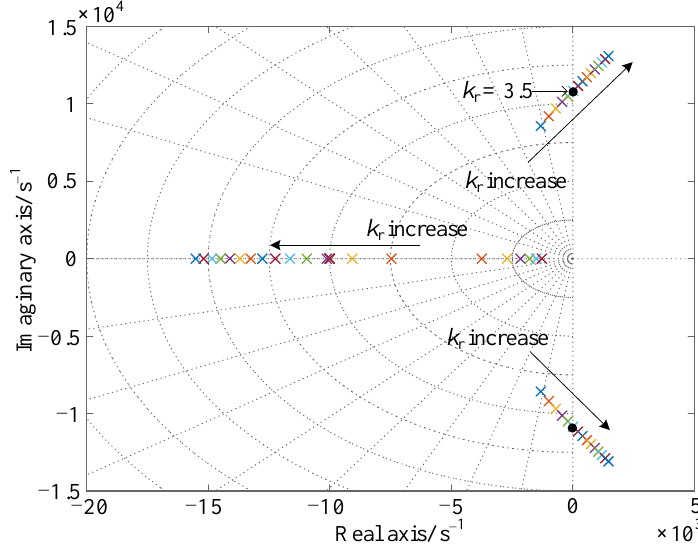
Figure 12. The pole distribution diagram of G i_cl ( s ) under different k r . In order to theoretically prove the suppression effect of G R ( s ) on the 6th harmonic component in i d , when k r increases from 1 to 3, the bode plot of G u_i ( s ) is shown in Figure 13. Due to the addition of G R ( s ), the amplitude around 1000 Hz is below 0 dB line. And with the increase of k r , the suppression effect on the 6th harmonic component in i d is more significant, and the band of the voltage harmonic frequency that can be suppressed by the G R ( s ) will also expand. Although another peak appears, the amplitude of the harmonic components of the inverter output voltage in d-q axis is very few, so it will not cause additional harmonic distortion. However, to prevent increasing the eleventh and thirteenth harmonics of stator current, the cut-off frequency of G u_i ( s ) should be less than the twelfth harmonic frequency.